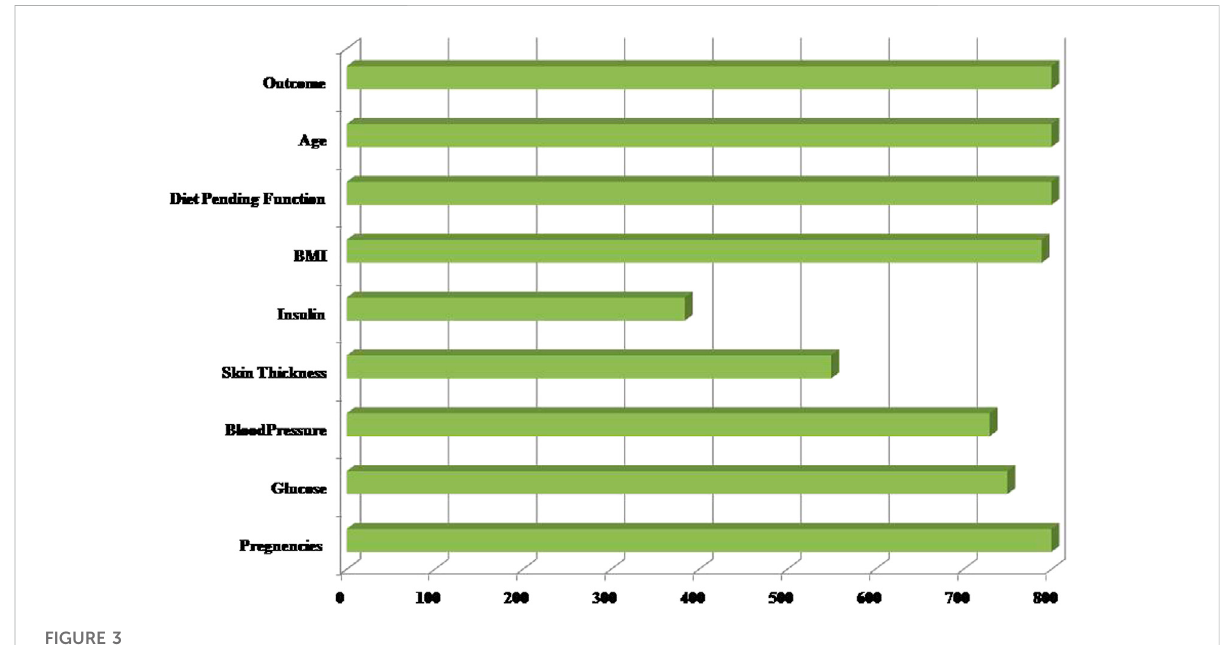
FIGURE 3 The Dataset attributes and Missing Values